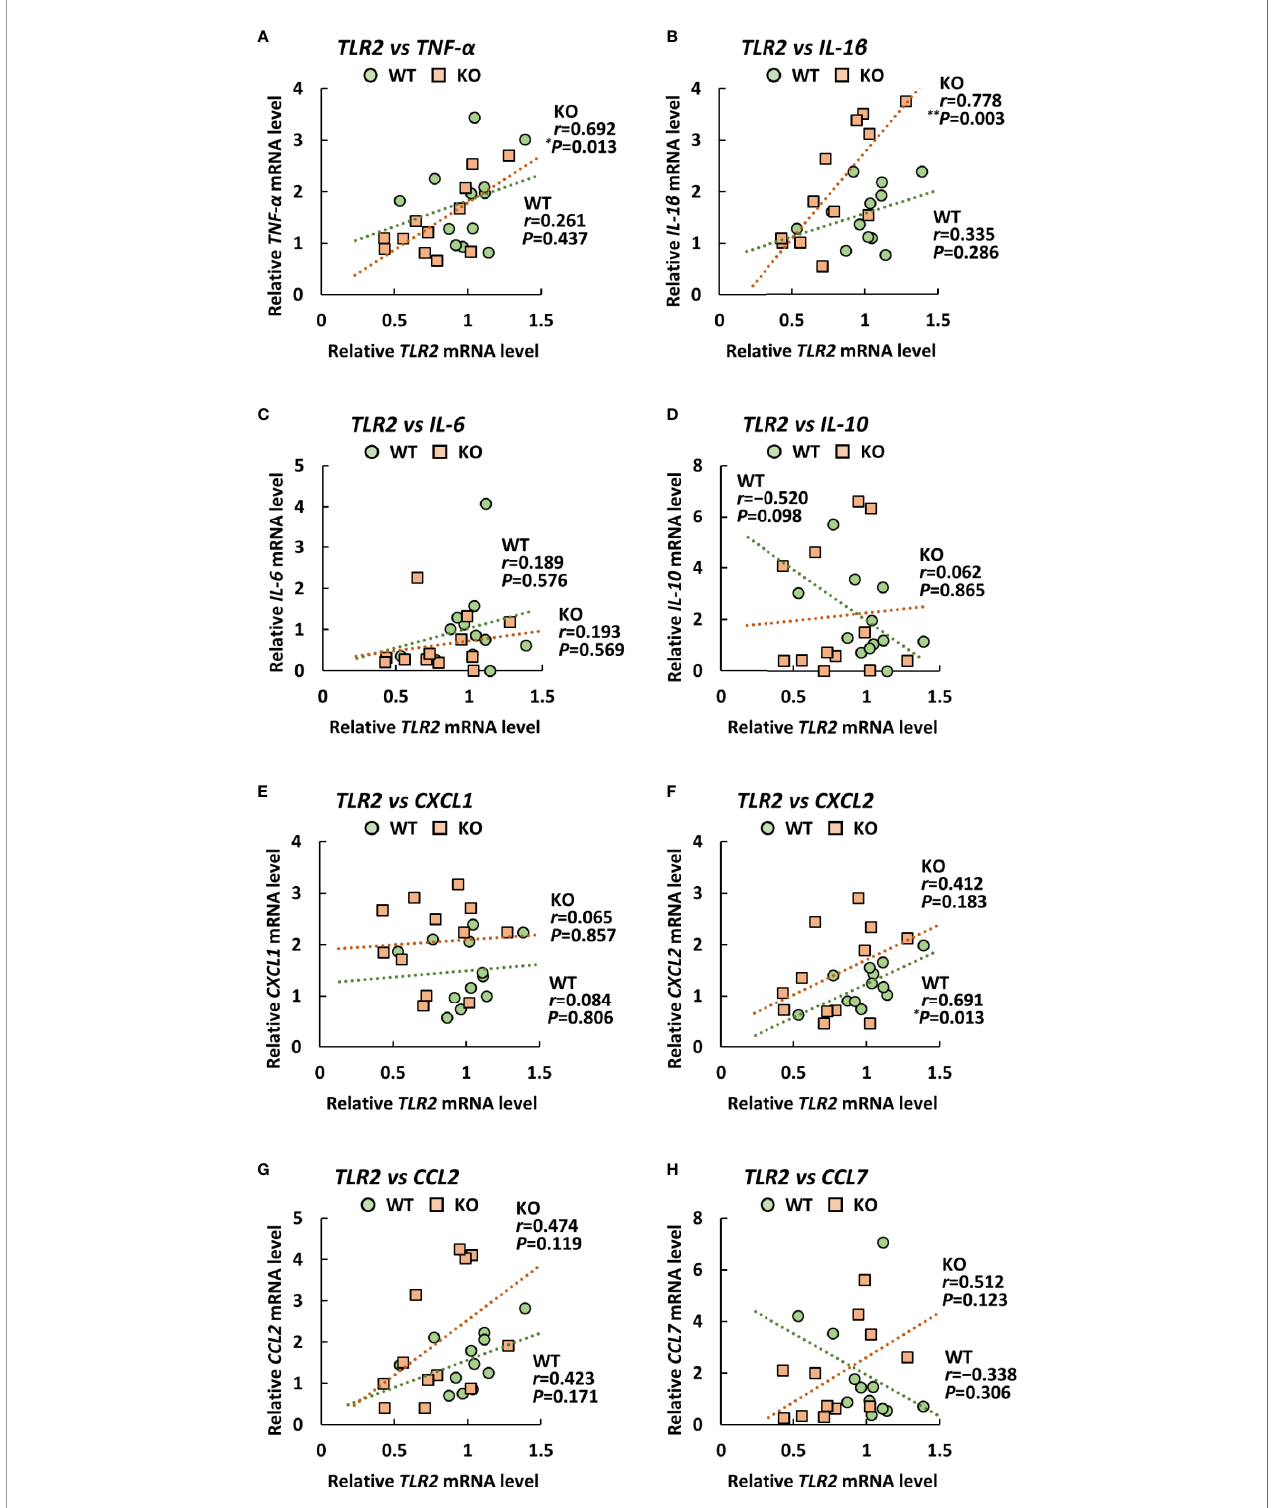
FIGURE 5 | Relationship between the expression of proin fl ammatory cytokines and Toll-like receptor 2 ( TLR2 ) in klotho wildtype (WT) and knockout (KO) mice. Pearson correlation coef fi cient was calculated between the mRNA level of TLR2 and that of (A) TNF- a , (B) IL-1 b , (C) , IL-6 (D) IL-10 , (E) CXCL1 , (F) CXCL2 , (G) CCL2 , (H) CCL7 in klotho WT and KO mice. Each symbol represents one mouse. Asterisks indicate statistically signi fi cant correlations (** P < 0.01; * P <